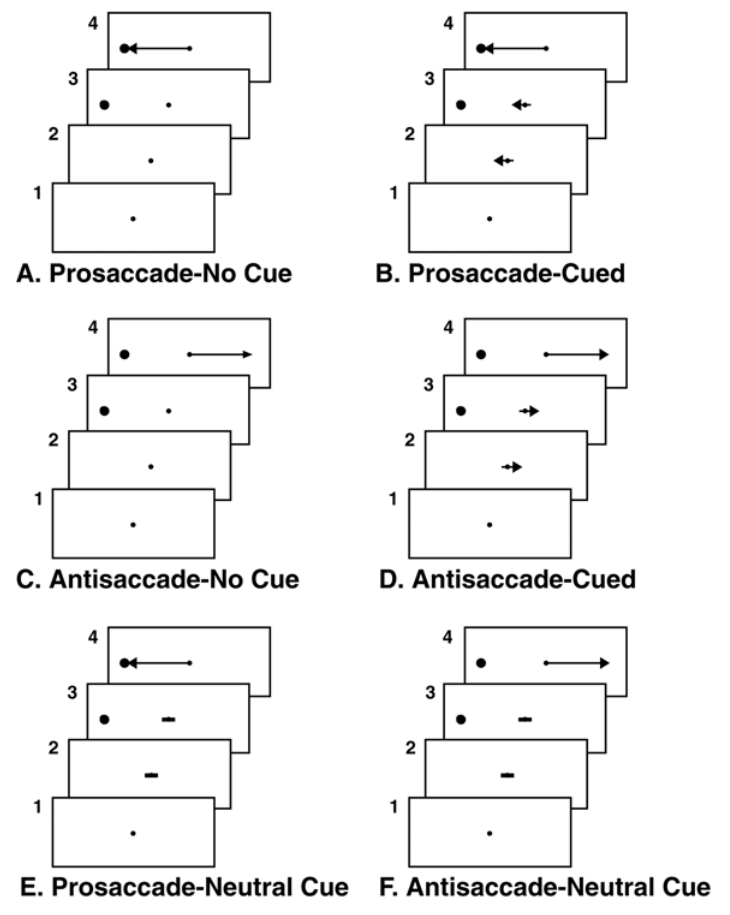
FIGURE 1. Prosaccade and Antisaccade Tasks. Schematic representation of a trial in the prosaccade task with no cue (panel A), prosaccade task with cue (panel B), antisaccade task with no cue (panel C), and antisaccade task with cue (panel D), prosaccade task with neutral cue (panel E), and antisaccade task with neutral cue (panel F). Each trial began with (1) the presentation of a fixation screen (a blank screen with a gray central fixation point) presented for 800 ms, followed by (2) a variable delay with either a fixation point (tasks with no cue, panels A and C), an arrow predictive of the upcoming eye movement (tasks with cue, panels B and D), or a neutral cue (panels E and F); then (3) presentation of the target accompanied by a brief audible tone, (4) the long arrow illustrates the correct eye movement response for the